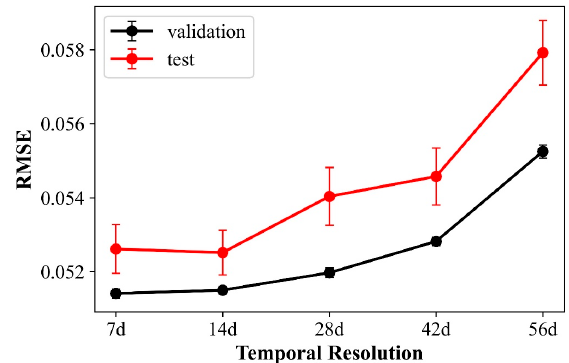
Figure 12. The sensitivity of shrub monitoring accuracy to the temporal resolution of vegetation index time series. Dots and bars represent the mean and standard deviation of repeated cross-validation accuracy, respectively.